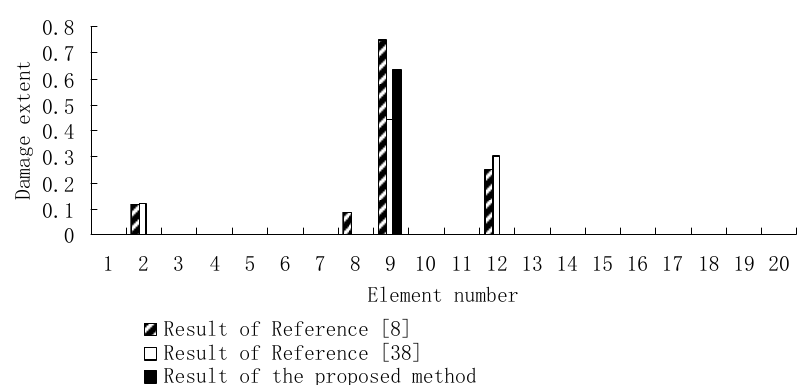
Figure 27. Comparison of damage evaluation results by the three methods.